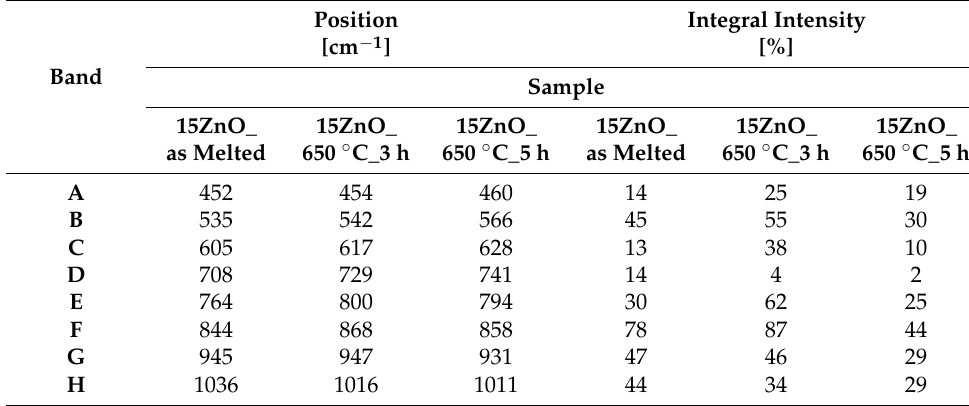
Figure 4. MIR spectrum of the 15ZnO glass-ceramics sample obtained after HT@650C for ( a ) 3 h, ( b ) 5 h. Table 1. Parameters of component bands in MIR spectra.